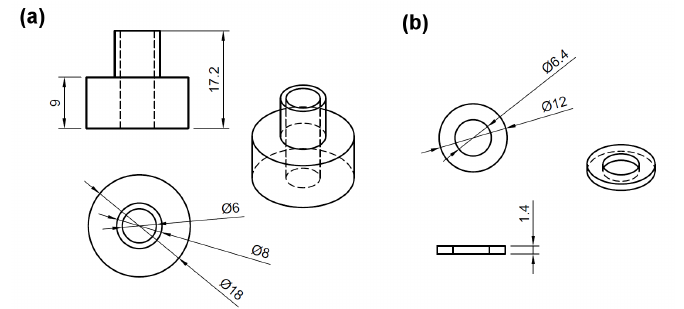
Figure 13. Schematic representation of the bush-bearing used at the long arm pivot position ( a ) is the main body of the bearing, ( b ) is a washer that maintains the bar in place. Sizes shown are just for reference and have not been optimized. The design will require adjustments.